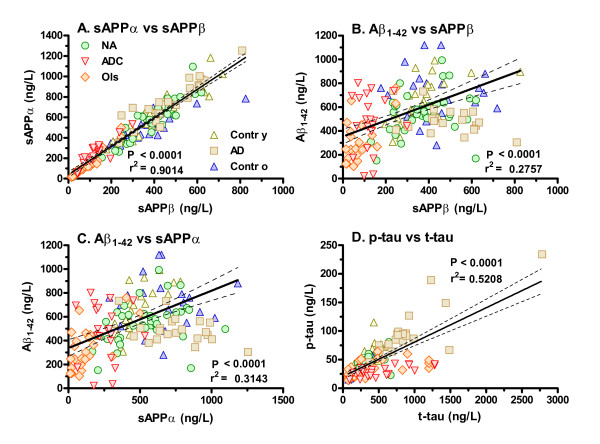
Selected marker correlations across patient groups. The four panels show relationships between markers: Panel A between sAPPα and sAPPβ, Panel B between Aβ1-42 and sAPPβ, Panel C between Aβ1-42 and sAPPα, and Panel D between p-tau and t-tau. Symbols for all four panels are defined in Panel A. The diagonal lines show linear regressions with 95% confidence intervals; each panel lists the P value and r2 for the regression. Abbreviations are those given in Figure 1.